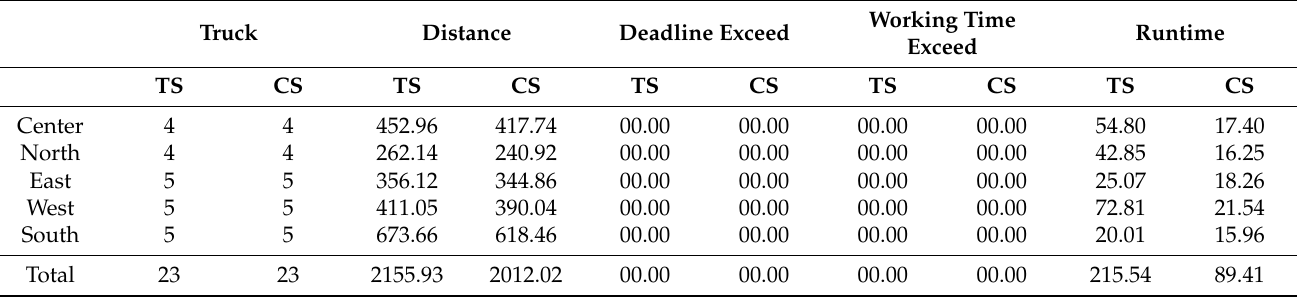
Table 4. TS and CS results for the real